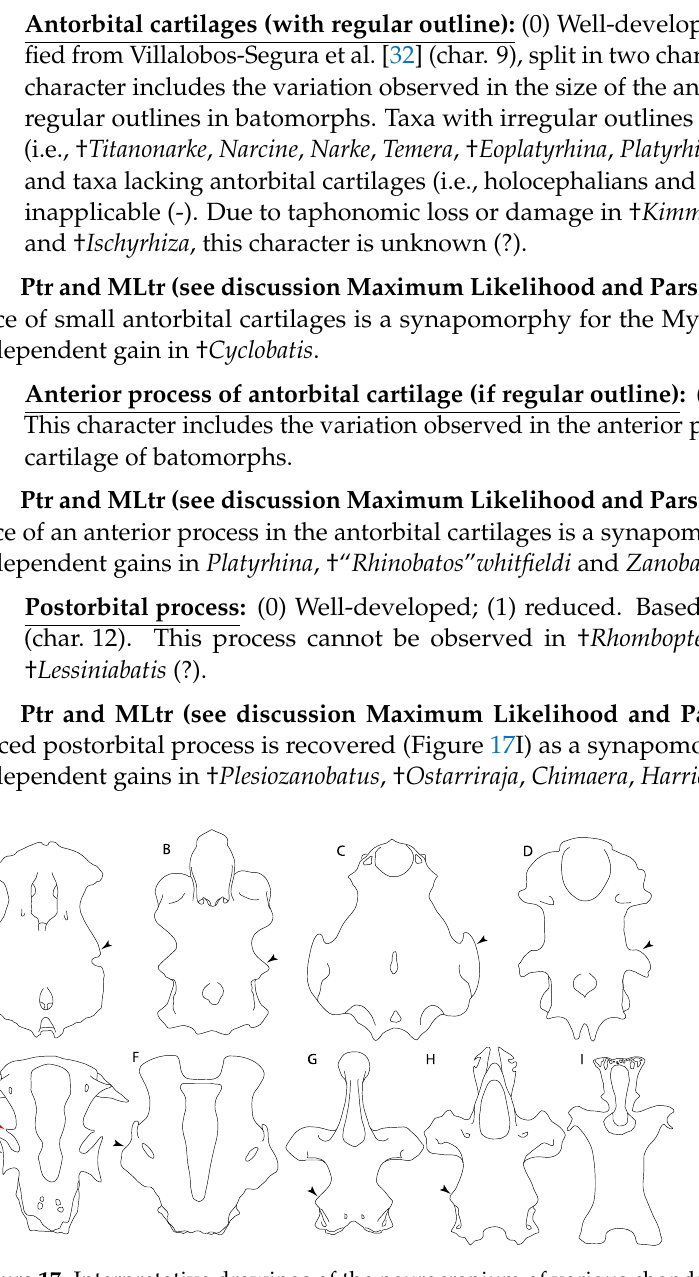
Figure 17. Interpretative drawings of the neurocranium of various chondrichthyans in dorsal view. State (0): ( A ) Heterodontus francisci. (AMNH 217862); ( B ) Squalus acanthias redrawn from Thomas et al. Text-Figure 1 in [81] and Maisey Text-Figure 15A in [86]; ( C ) † Egertonodus († Hybodus ) basanus redrawn and modified from Maisey Text-Figure 15C in [86]; ( D ) Chlamydoselachus africana (SAM 36076), redrawn and modified from Ebert and Compagno Text-Figure 4 in [87]; ( E ) Gymnura japonica (HUMZ 4830), redrawn and modified from Nishida Text-Figure 15A in [82]; ( F ) Rhinoptera javanica (HUMZ 97698), redrawn and modified from Nishida Text-Figure 17A in [82]; ( G ) Trygonorrhina fasciata (MCZ 982S), after McEachran et al. Text-Figure 7 in [38]; ( H ) Platyrhinoidis sp. redrawn and modified from Nishida Text-Figure 7G in [82]. State (1): ( I ) Torpedo ocellata (AMNH 4128). Black arrowheads: postorbital process; red arrowheads: triangular